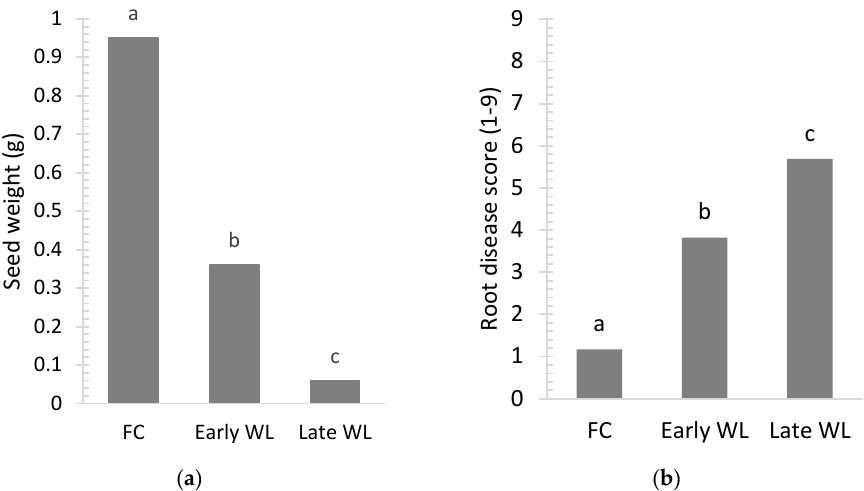
Figure 2. Main effects of waterlogging (WL) treatments (field capacity (FC), early WL and late WL) on ( a ) seed weight ( p < 0.001) and ( b ) root disease (1 good – 9 poor) ( p < 0.001) in a three-way analysis with three chickpea genotypes with or without Phytophthora medicaginis infection. Letters indicate significant differences.